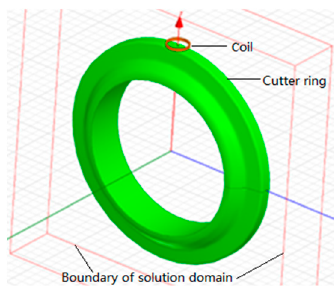
Figure 4. Simulation model